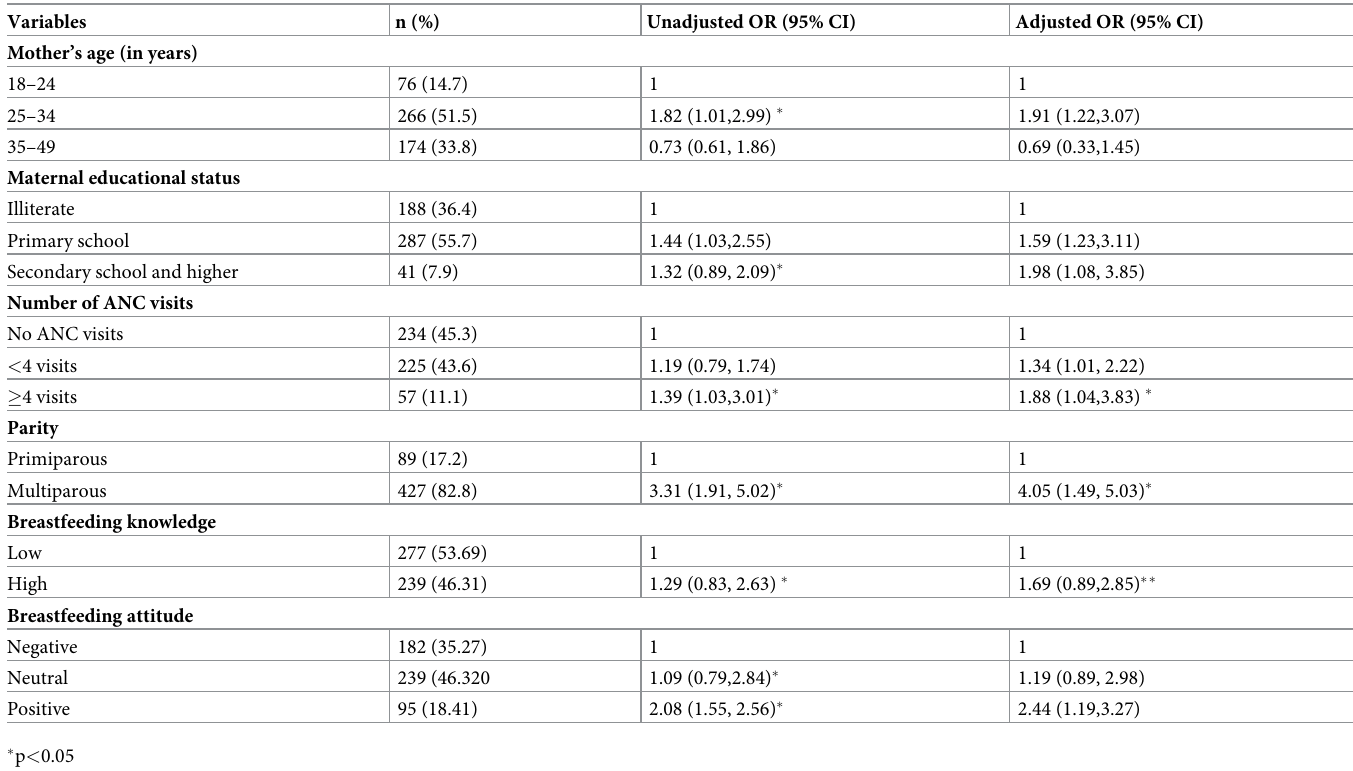
Table 5. Association between breastfeeding self-efficacy and their